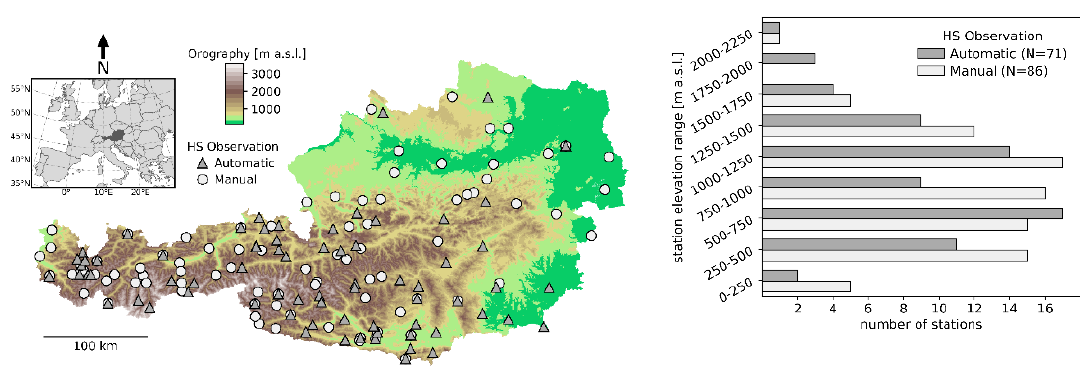
Figure 1. SNOWGRID-CL (SG-CL) model domain (visualized by topography), validation stations (Snowpat and TAWES stations), and their altitudinal distribution.